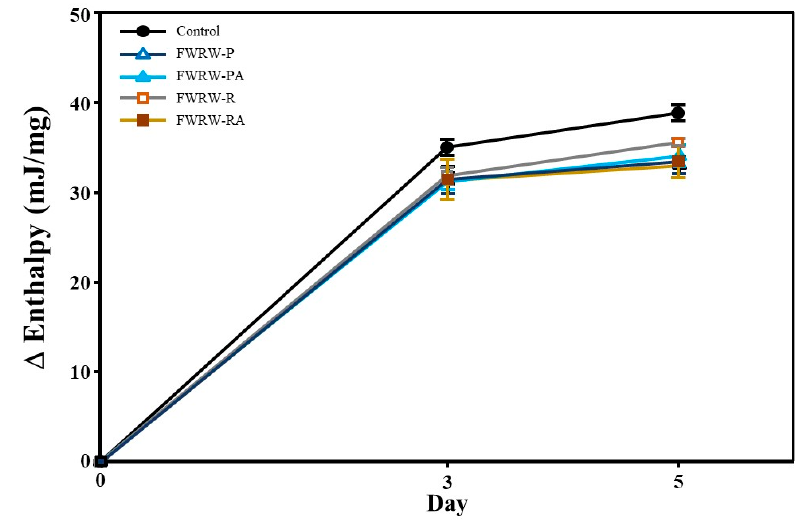
Figure 5. Retrogradation rates of the FWRW-treated garaetteok . Closed circle: control; open triangle: FWRW-P; closed triangle: FWRW-PA; open square: FWRW-R; closed square: FWRW-RA.